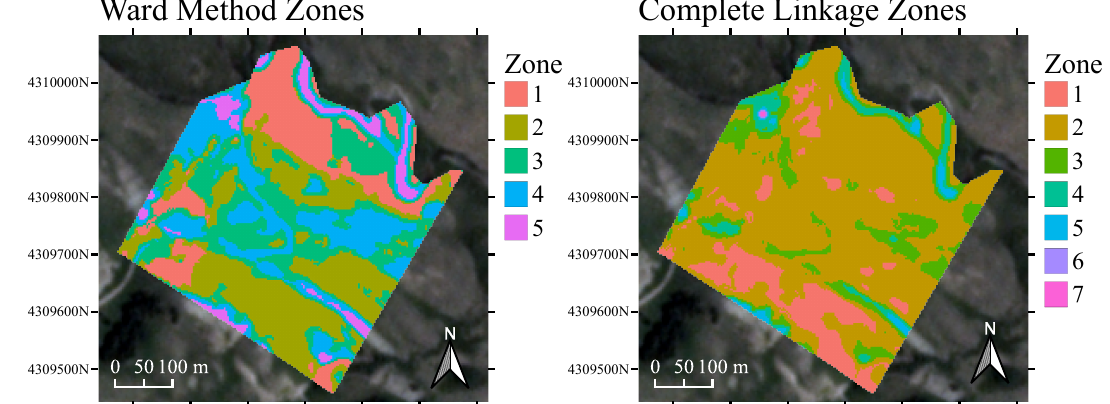
Figure 7. Zonation maps based on ( a ) Ward and ( b ) complete linkage clustering methods. These zones are derived through clustering pixels, with a distinct NDVI time series associated with each pixel. Five clusters (corresponding to 5 spatial zones) were identified by the Ward method, while 7 clusters were identified by the complete linkage method.